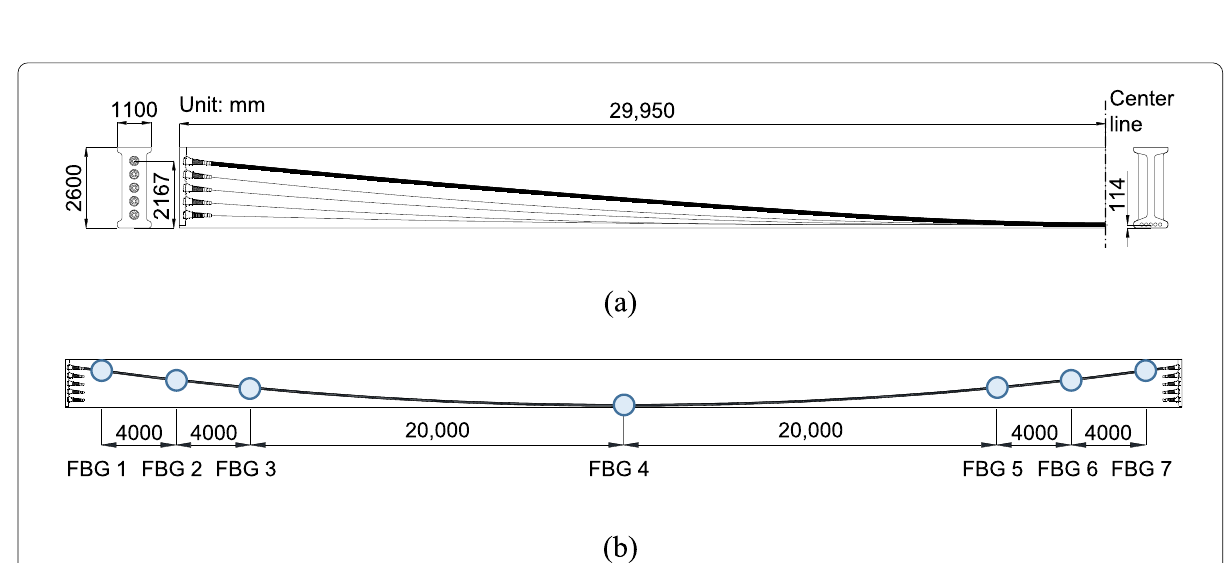
Fig. 6 Prestressed concrete (PSC) girder in bridge A: a Dimensions and arrangement of tendons; b location of the Smart Strand and fiber Bragg gratings (FBGs) (girders 1 and